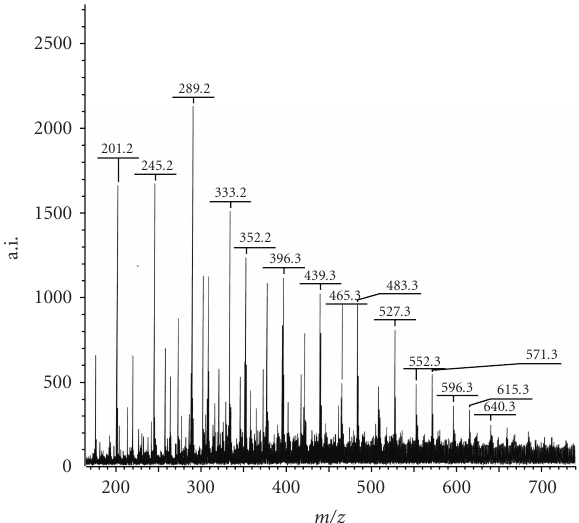
Figure 4: MALDI ToF spectrum of reaction product of BHEOA:EC 1:6 in the presence of 0.06mole K 2 CO 3 /mole at 160 ◦